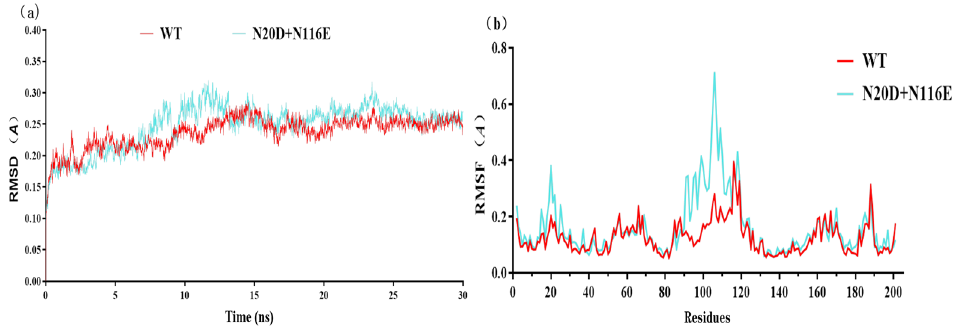
Figure 7. Molecular dynamics simulations of wild-type BsNox and its variant N20D/N116E. ( a ) The RMSD values of WT and its variant N20D/N116E. ( b ) The RMSF values of WT and its variant N20D/N116E.